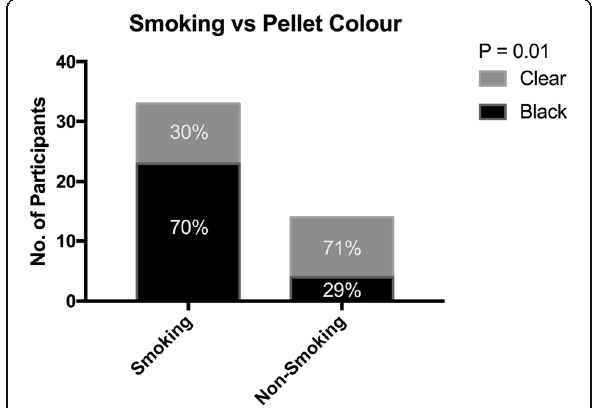
Fig. 3 BALC pellet colour (black or clear) shown for smoking and non-smoking study participants. Significance determined at P < 0.05 using Fisher ’ s exact